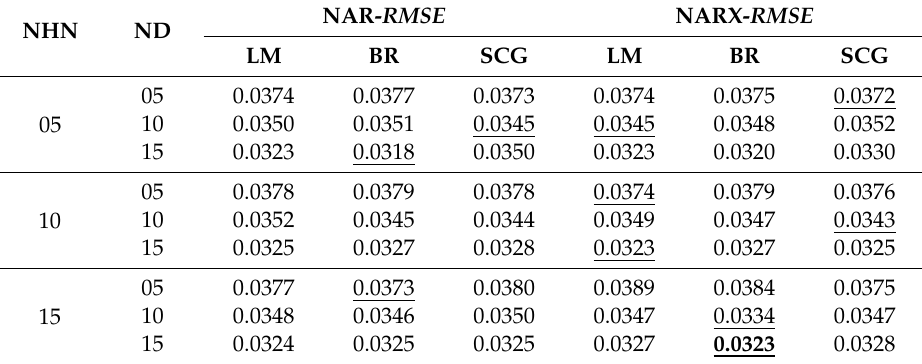
Table 8. Benchmark evaluation with nonlinear autoregressive methods based on RMSE